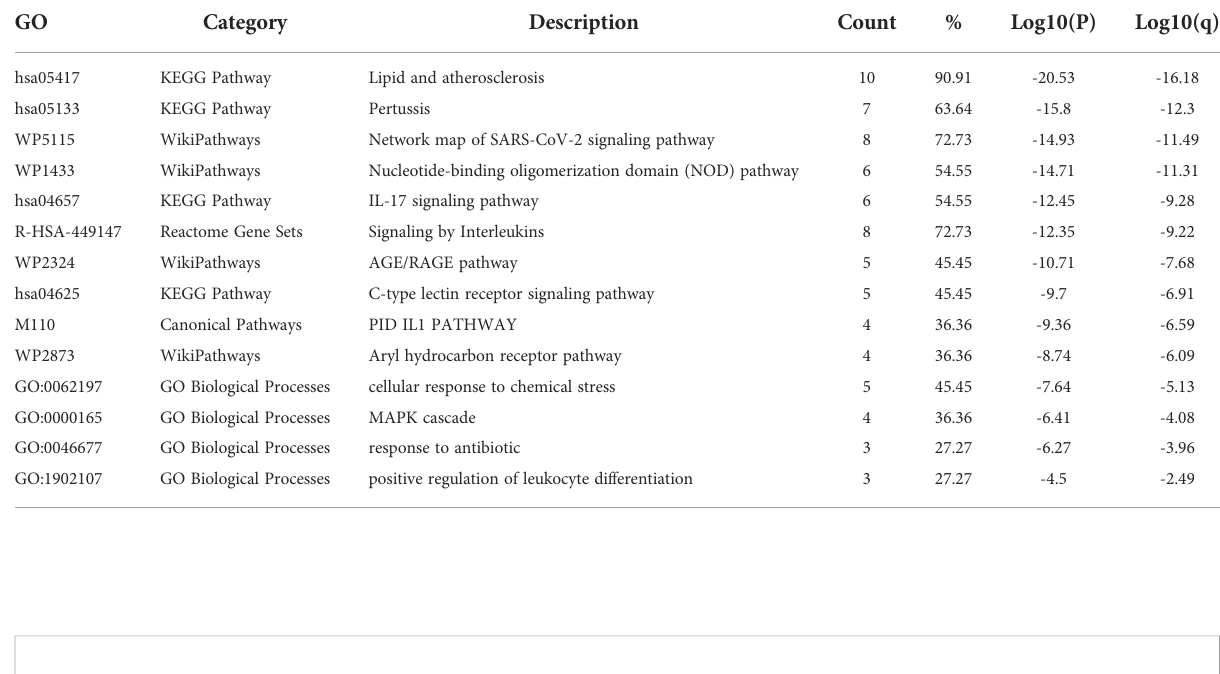
TABLE 2 Pathway and Process Enrichment Analysis in metascape.